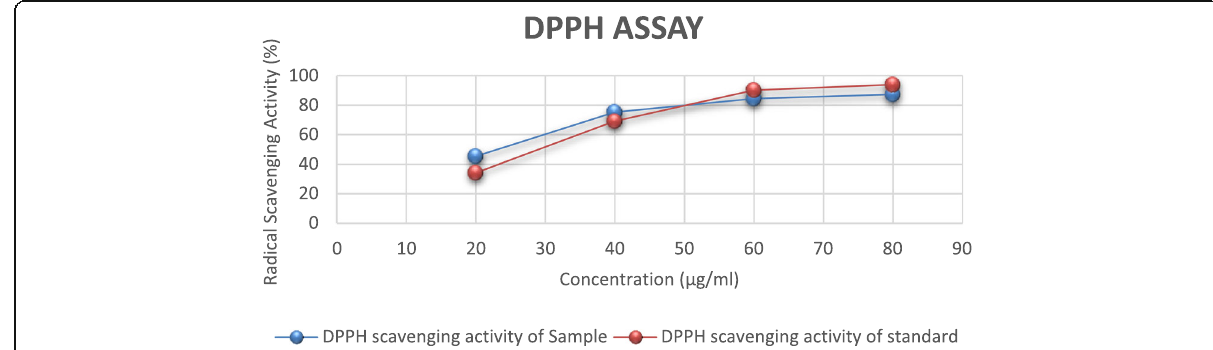
Fig. 4 Comparative analysis of radical scavenging activity(percentage) among Sterculia urens Roxb. root extract and ascorbic acid